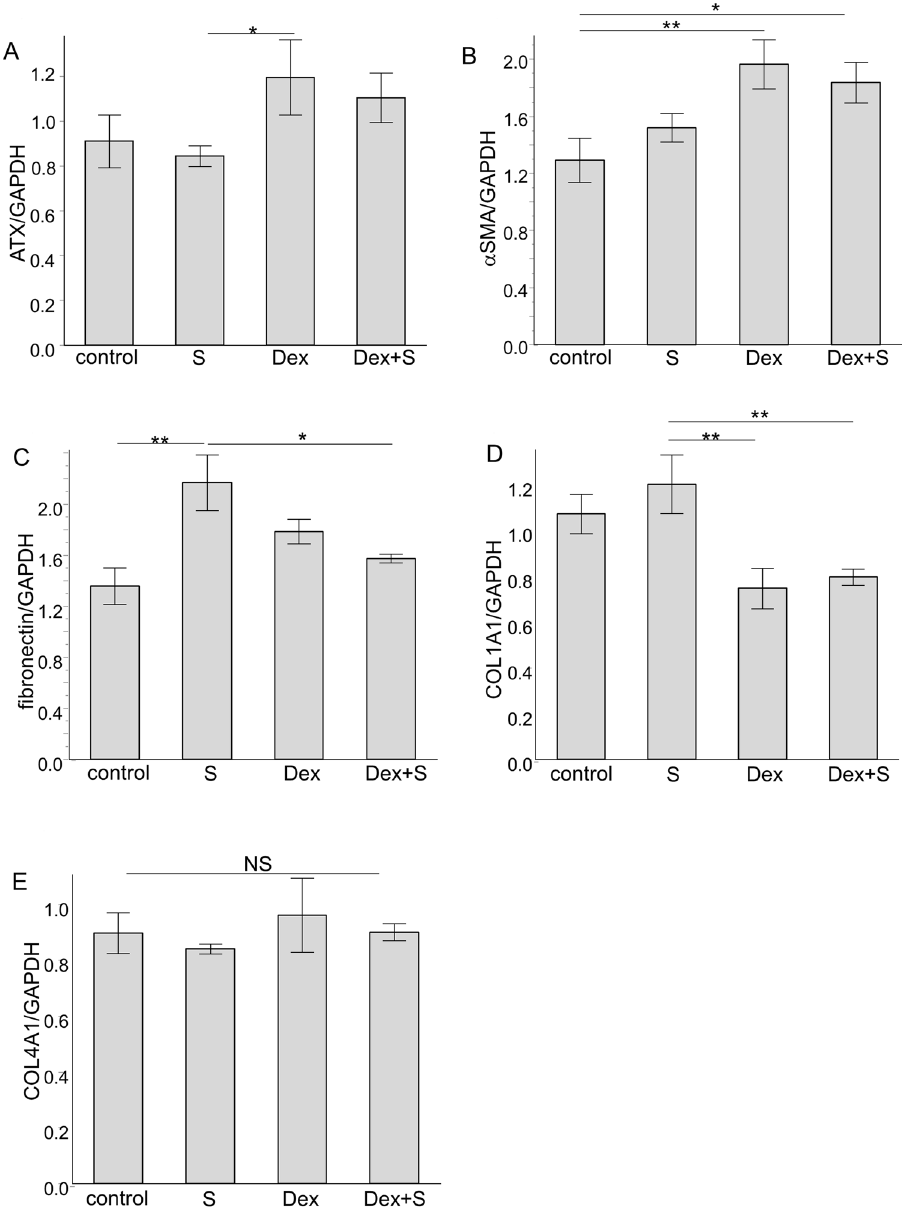
Figure 3. Expression levels of ATX and fibrotic markers in hTM cells. ( A ) The relative mRNA expression of ATX was significantly higher in the Dex group. ( B ) Alpha smooth muscle actin (αSMA) was significantly higher in the Dex and Dex + S groups compared with the control. ( C ) Fibronectin was significantly upregulated in the S group, and the upregulation was suppressed by Dex treatment. ( D ) COL1A1 was higher in the S group but lower in the Dex and Dex + S groups. ( E ) COL4A1 showed no significant changes. RT-qPCR was performed with GAPDH primers as an internal control for input DNA. Data are the average values of four independent DNA samples from treated cells. * P < 0.05; ** P < 0.01; hTM: human trabecular